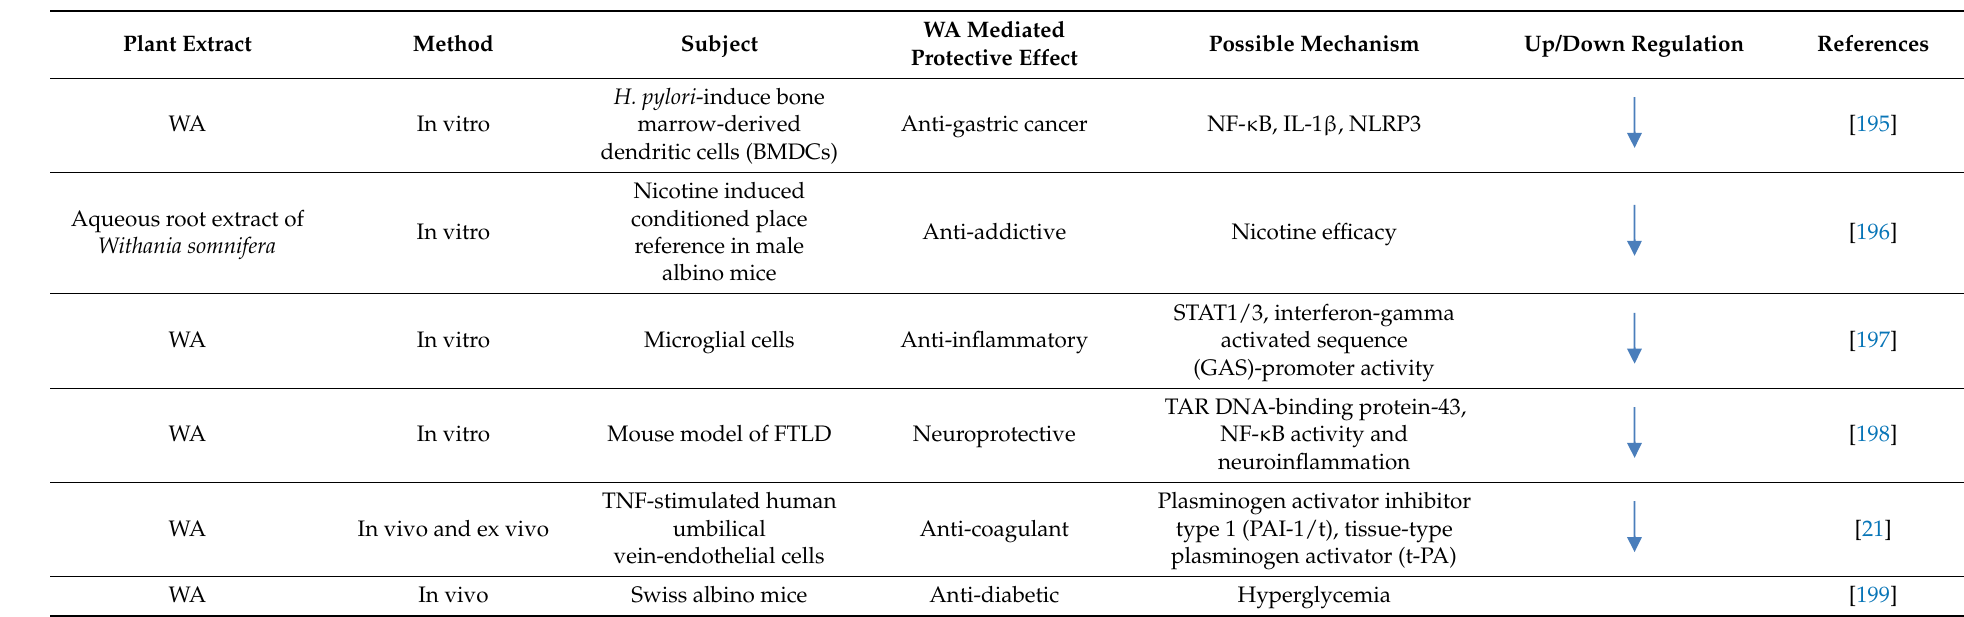
Table 1. Cont. Table 1. Preclinical trials of WA.